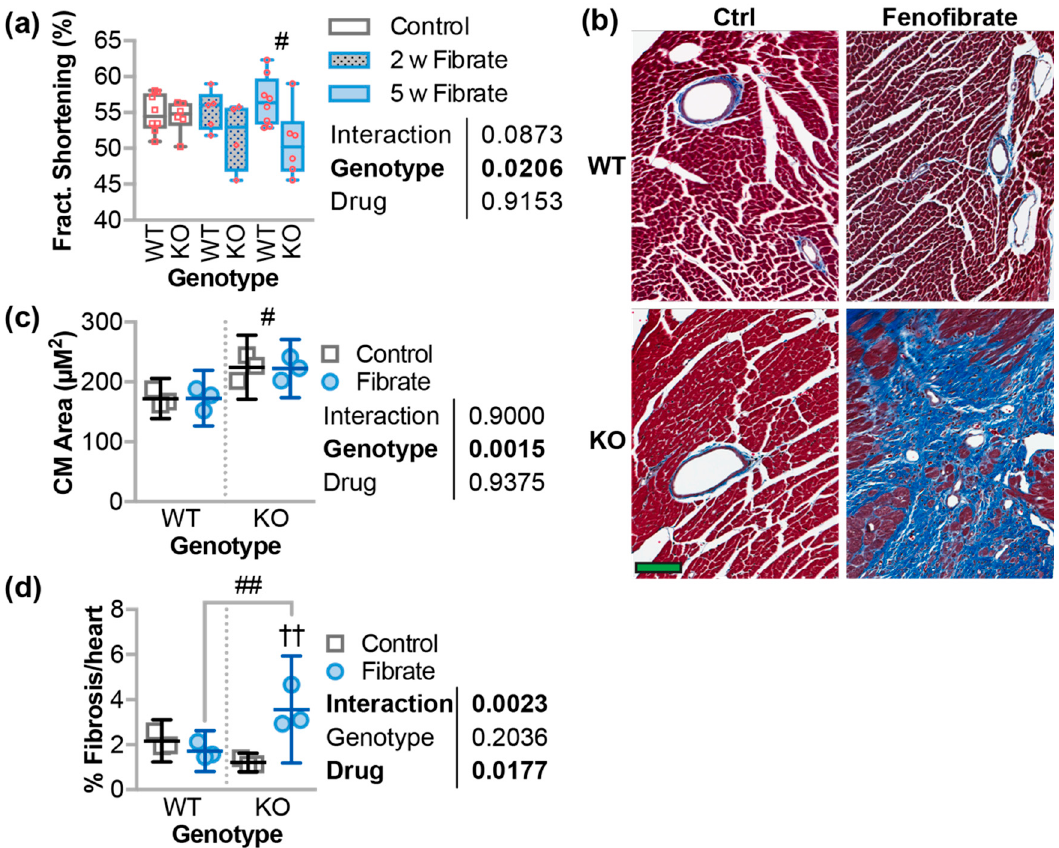
Figure 5. Changes in cardiac function and structure due to fenofibrate. ( a ) Fractional (fract.) shortening over the time course of the study, which is represented by boxplot with biological replicates plotted. Results of two-way ANOVA are provided. Tukey’s post-test: # p < 0.05 comparing wild-type (WT) vs. CHIP − / − (KO) conditions. ( b ) Micrographs of Masson’s trichrome staining of heart sections in which the scale bar represents 100 microns. ( c ) Cardiomyocyte area and ( d ) the percentage of fibrotic cardiac tissue represented by dot plot and summarized by the mean ± 95% CI, N = 3 animals per genotype per condition. The results of two-way ANOVA are provided. Tukey’s post-test: # and ## p < 0.05 and 0.01 comparing WT vs. KO conditions; †† p < 0.01 control vs. fibrate conditions.